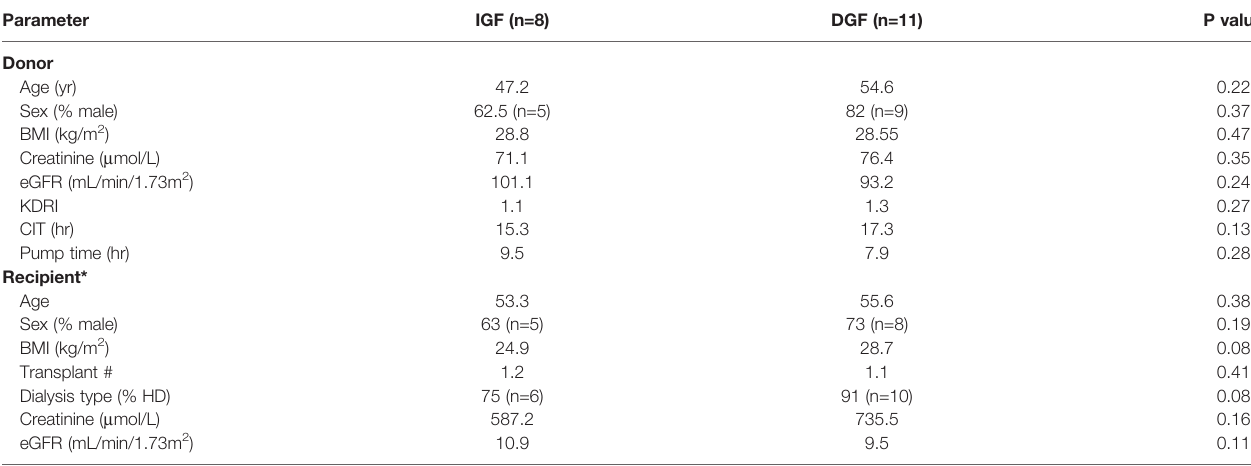
TABLE 1 | Donor and recipient characteristics in IGF and DGF